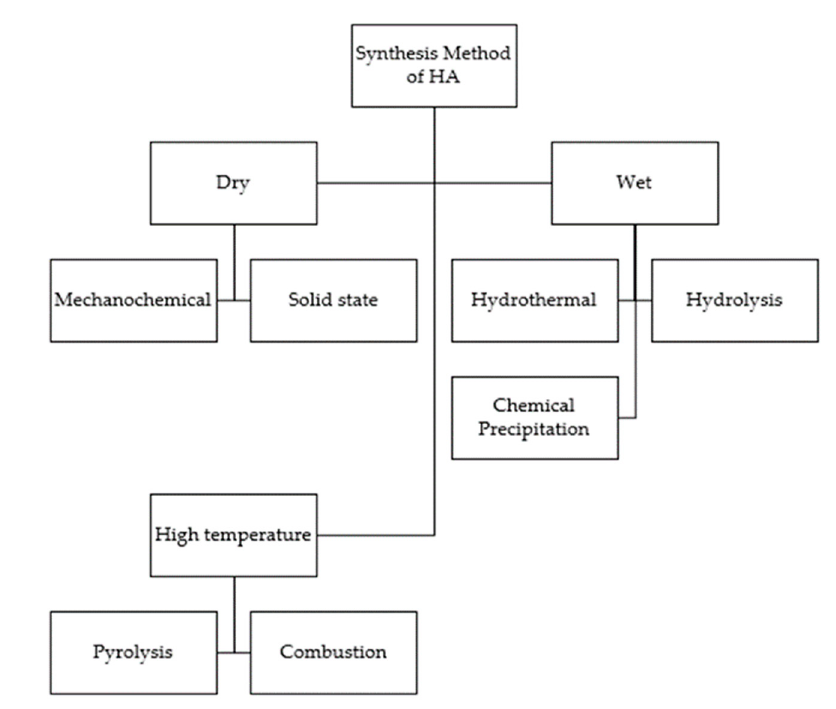
Figure 4. Classification synthesis method of HA, adopted from [40]